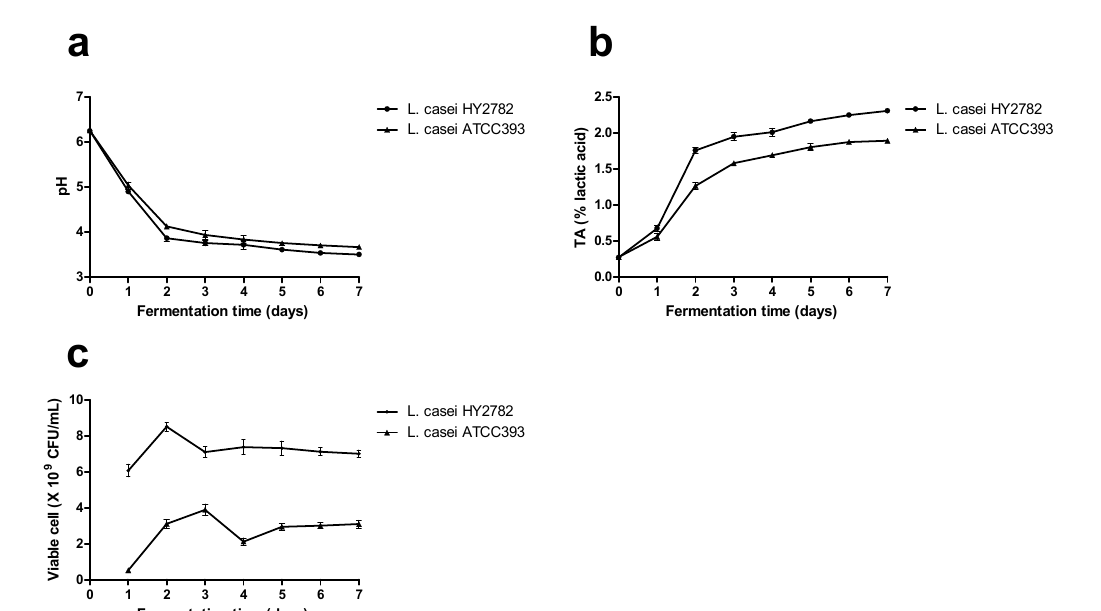
Figure 1. Physiochemical characteristics of fermented milk with Lactobacillus casei HY2782 or L. casei ATCC393. ( a ) pH, ( b ) titratable acidity (TA), and ( c ) total number of viable cells versus fermentation time throughout milk fermentation with L. casei HY2782 or L. casei ATCC393. Results are expressed as the mean ± SD of three independent experiments ( n = 3).